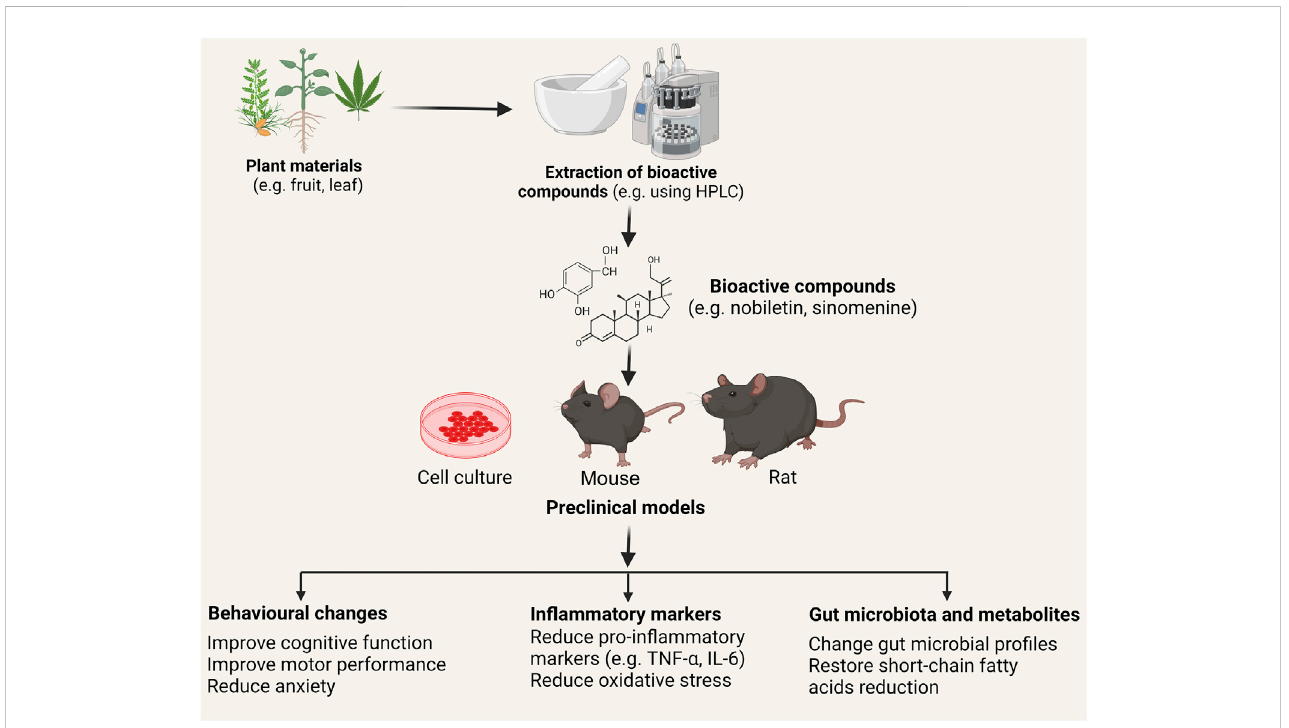
FIGURE 1 Schematicoftheuseofplant-derivedbioactivechemicalsinmitigatingin fl ammation.Variousplant(e.g. Citrusdepressa,Sinomeniumacutum )materials including leaves, fl ower, stems, fruits contain naturally derived anti-in fl ammatory bioactive compounds. These compounds (e.g., nobiletin, sinomenine, cannabidiol, and tanshinone IIA) are extracted (commonly using homogenization and high-performance liquid chromatography; HPLC analysis) and tested in vitro and in vivo to investigate the effect in the resolution of neuroin fl ammation and neurodegeneration. Studies showed that treatment with the bioactivecompoundsimprovedbehaviouralde fi cits(e.g.,motor,anxiety,andcognition),reducedpro-in fl ammatorymarkerssuchastumournecrosisfactor- α (TNF- α ) and interleukin-6 (IL-6), and alters gut microbial pro fi les and their metabolites (e.g. short-chain fatty acids). Following clinical validation and approval, these pharmaceuticals ’ compounds can be used in treating neuroin fl ammatory and neurodegenerative diseases such as Alzheimer ’ s